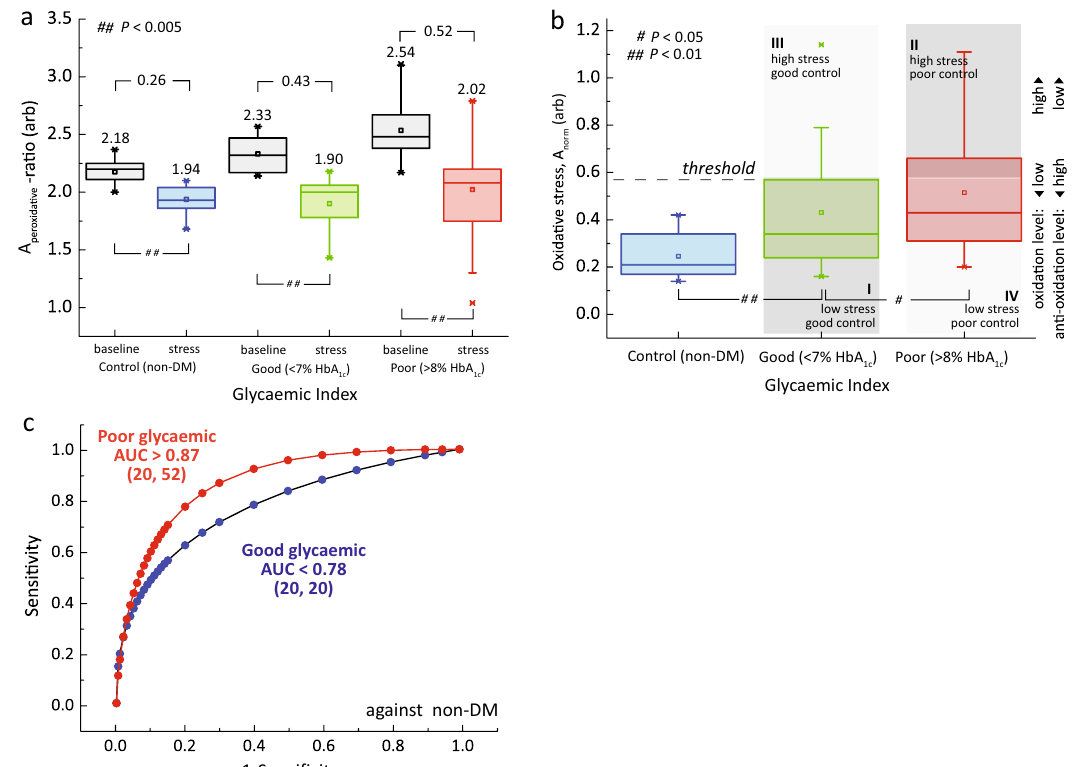
Fig. 6 Peroxidative stress test on plasma. a The A peroxidative -ratio plot for plasma in baseline (black) and plasma pretreated with hydrogen peroxide (red, green, blue) for non-DM subjects ( n = 20), and DM subjects with their glycemic index in good glycemic control ( n = 20), and poor glycemic control ( n = 52) subgroups. The means and changes in each subgroups were indicated above the box-plots. b A quadrant chart of diabetic subjects strati fi ed into subgroups based on their peroxidative status (normalized A baseline – A stress ) in association with their glycemic levels (e.g., HbA 1c ). The threshold of A peroxidative -ratio was set at 75th percentile that of DM subjects with good glycemic control, and adjusting based on clinical needs (e.g., population genetics). Note that the Y-axis (peroxidative stress) is in analogous with Y-axis (nitrosative stress) in quadrant shown in Fig. 4b. The details of quadrant representations are shown in Fig. 1e. The statistical signi fi cance was calculated using the Student ’ s T-test (two-tailed, unequal variance). c The diagnostic accuracies were evaluated using Receiver Operating Characteristic (ROC) for non-DM subjects against DM subjects with good glycemic control (blue) and poor glycemic control (red) subgroups. The number of subjects ( n ) was indicated on the parentheses.